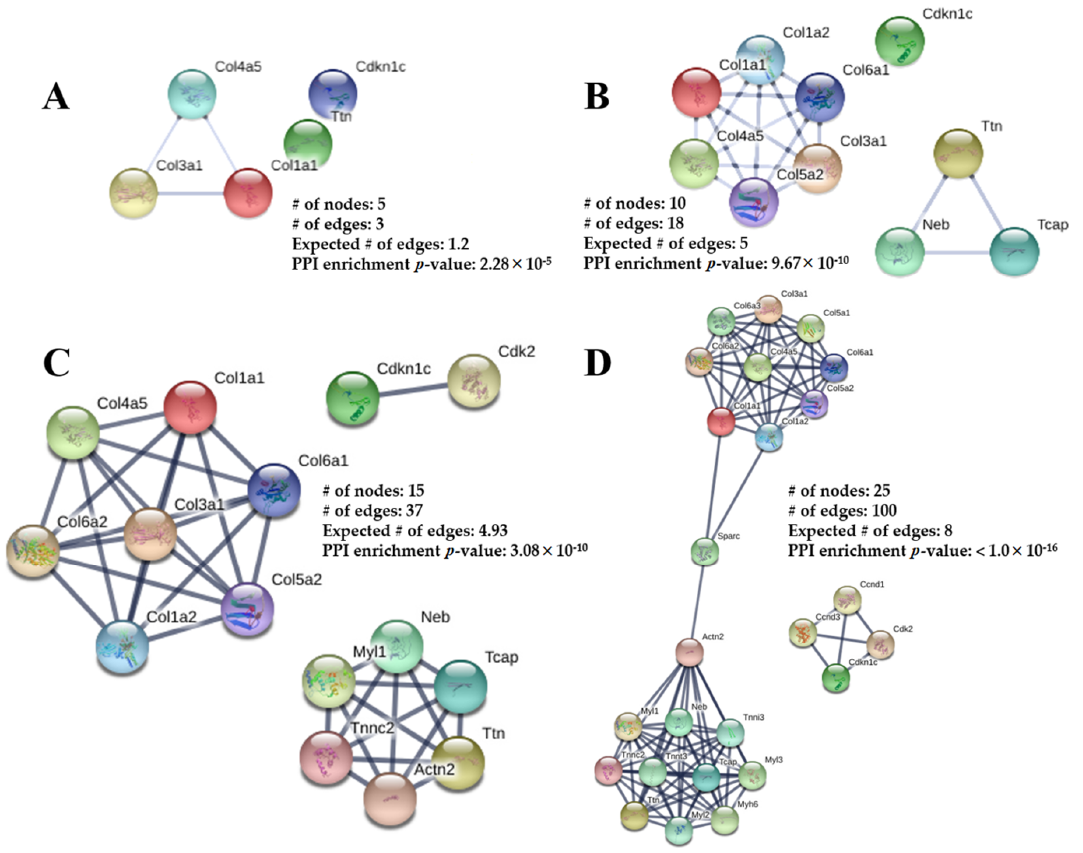
Figure 6. The Protein-Protein Interaction (PPI) networks constructed by the STRING database for Figure 6 the di ff erentially abundant proteins from PGR and CON mouse hearts. The networks consist of the total number of nodes (proteins involved), number of edges (PPI connections amongst nodes), and a PPI enrichment p -value. The expected number of edges provides how many edges are anticipated if the nodes were selected at random. ( A ) No interactors. ( B ) Five predicted protein interactors added. ( C ) Ten predicted protein interactors added. ( D ) Twenty predicted protein interactors added. The spheres represent the proteins and the line thickness represents the PPI-associated degree of evidence (combination of gene fusion, gene neighborhood, gene co-occurrence, experimental evidence, text-mining evidence, database evidence, and co-expression evidence). The information inside of the circle describes the protein structure and the color of the nodes is for visual